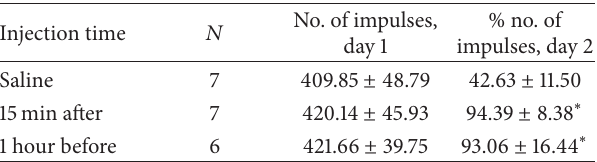
Table 1: The effect of a single dose of 25 mg/kg of imipramine administered one hr before or 15 min after training on day 1 on rat mobility in the forced swim